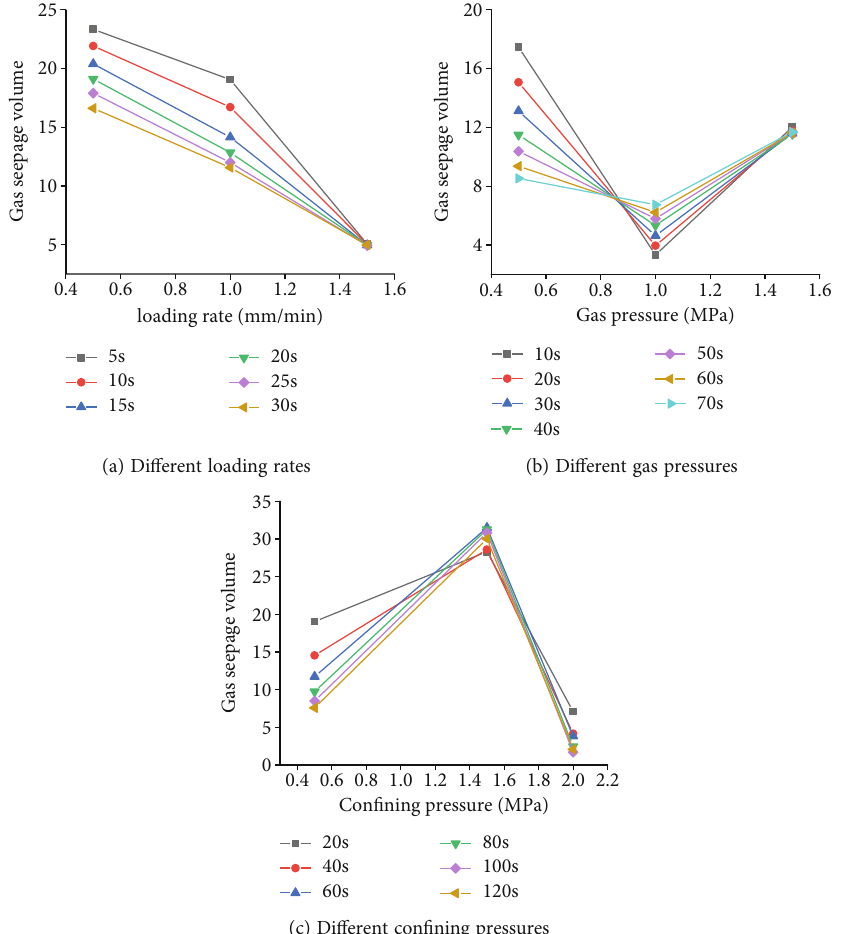
Figure 5: Gas seepage volume at the same time under di ff erent loading